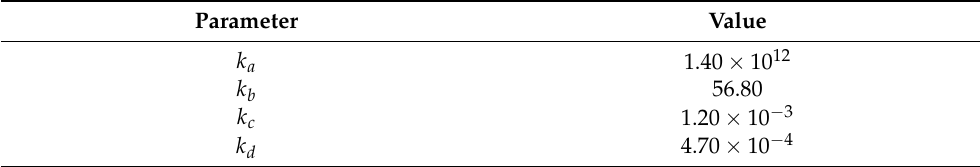
Table 3. Simulation parameter values.